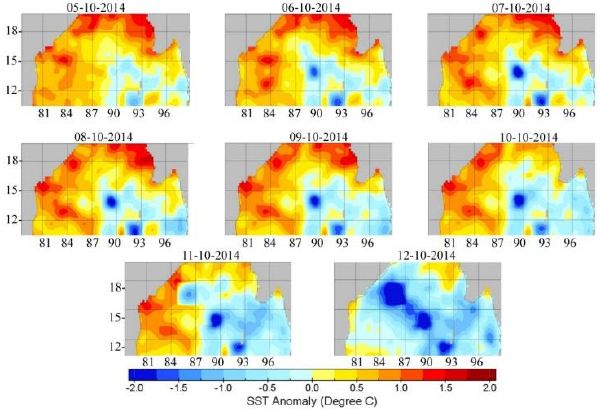
Figure 4. Sea surface temperature anomaly over Bay of Bengal and Andaman Sea. Intense warming is observed near Visakhapatnam coast during 7–11 October 2014.